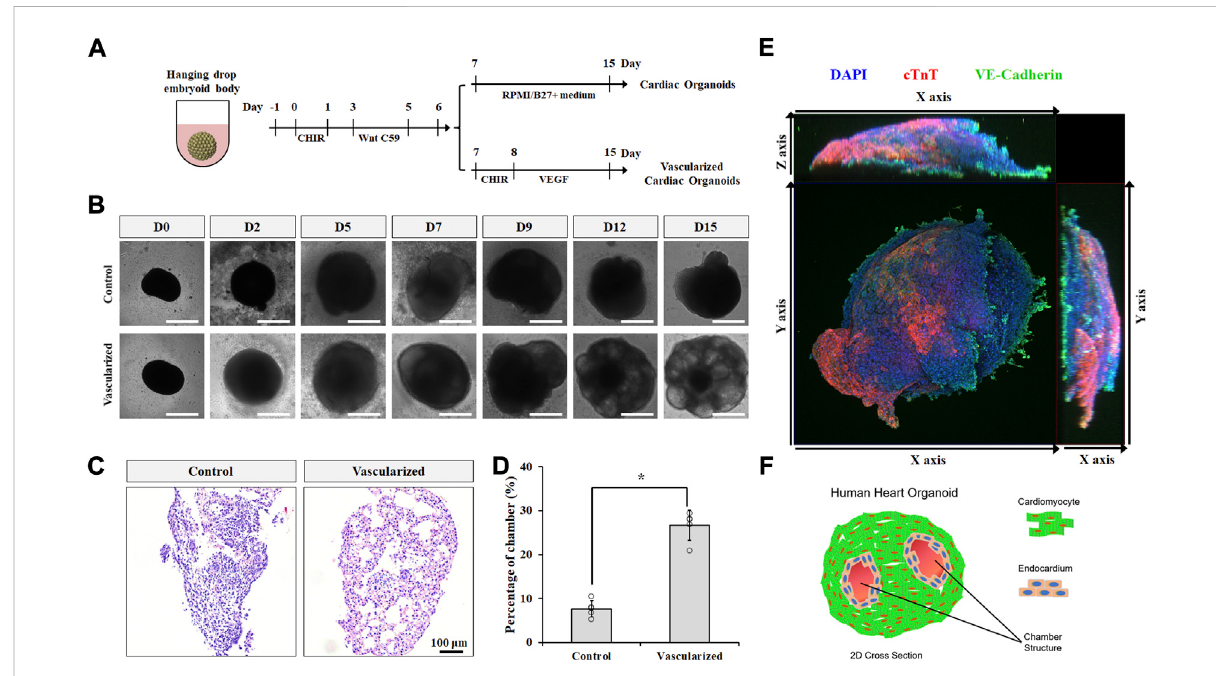
FIGURE 3 Vascularized cardiac organoids were derived from hPSCs. (A) Schematic of the protocol used to differentiate hPSCs towards vascularized cardiac organoids. (B) Bright fi eld images of hPSC-derived cardiac organoids atindicated days. (C) H&E staining showed sliced cardiac organoids. (D)